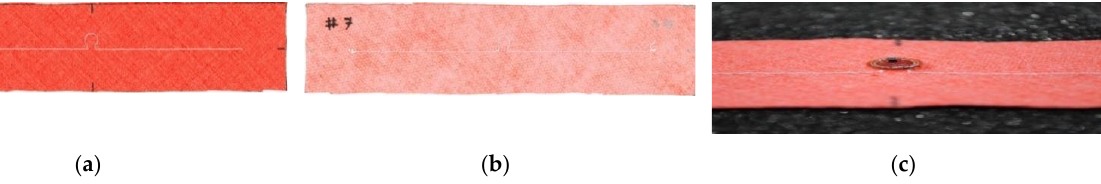
Figure 18. An example of the RFIDtex transponder — sample A7: ( a ) front of antenna; ( b ) back of antenna; ( c ) antenna and microelectronic module.